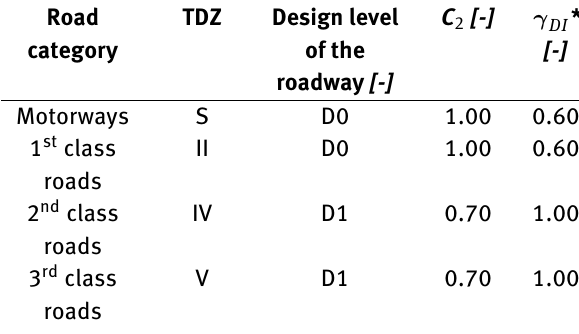
Table 2: Diversion route coeflcients by the road category [1,